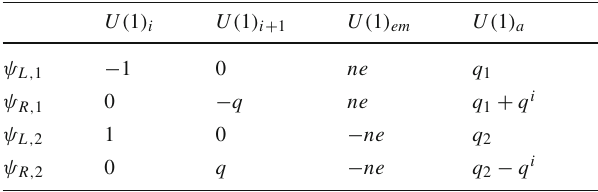
Table 1 Anomaly-free set of fermions coupling the ALP to the photon field (the three first columns indicate the gauge charges of the fields whereas the last one gives the PQ charges induced by (4.3), as functions of q 1 and q 2 which are